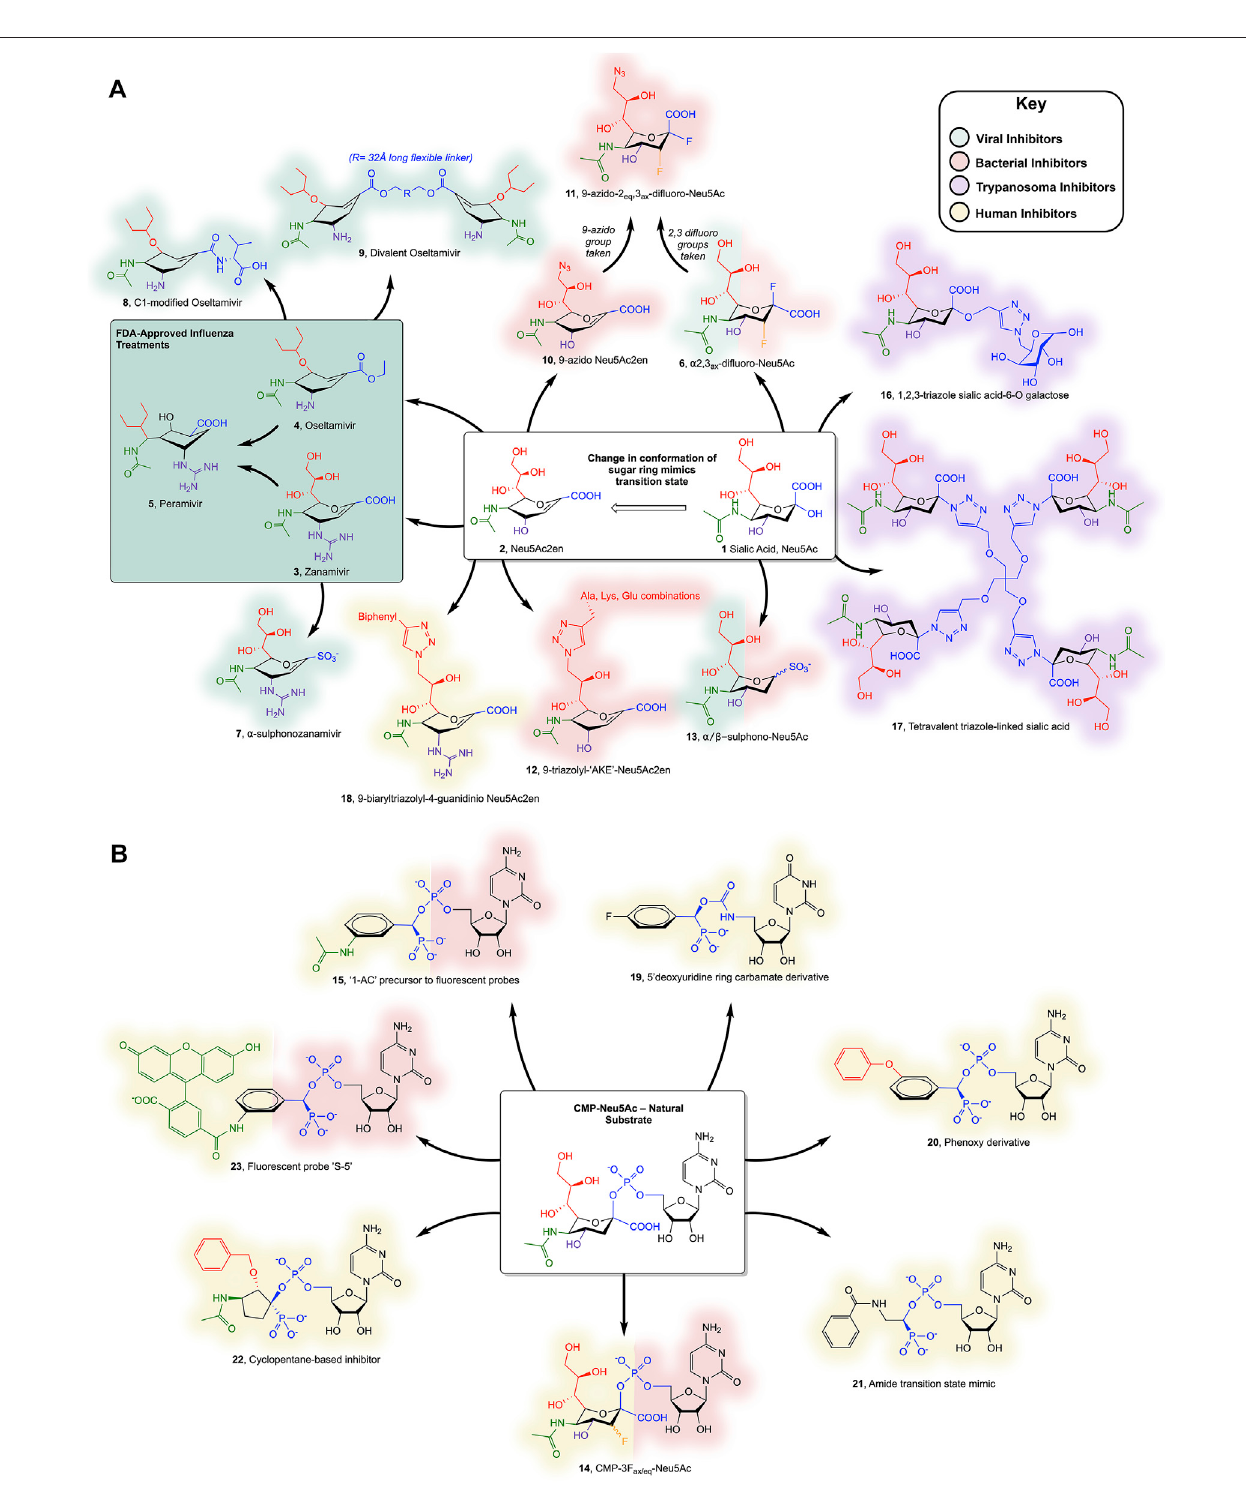
FIGURE 2 | (A) Sialic acid- and Neu5Ac2en-derived inhibitors of SAs and (B) CMP-Neu5Ac-derived inhibitors of STs discussed in the text. Colours surrounding eachcompoundrepresenttheorganismtheyinhibit(seekey);notethatcompounds6,13,14,and15inhibitmorethanoneorganismandsobothrepresentativecolours are shown. Individual substituents on the Neu5Ac or Neu5ac2en ring are colour coded to highlight changes to the scaffold.